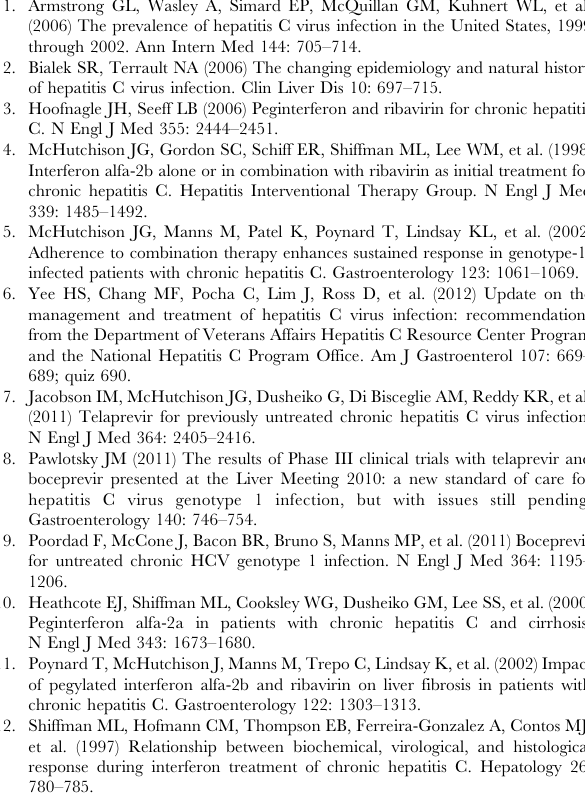
Table S1 Demographic and Clinical Characteristics of the UCSF Cohort.